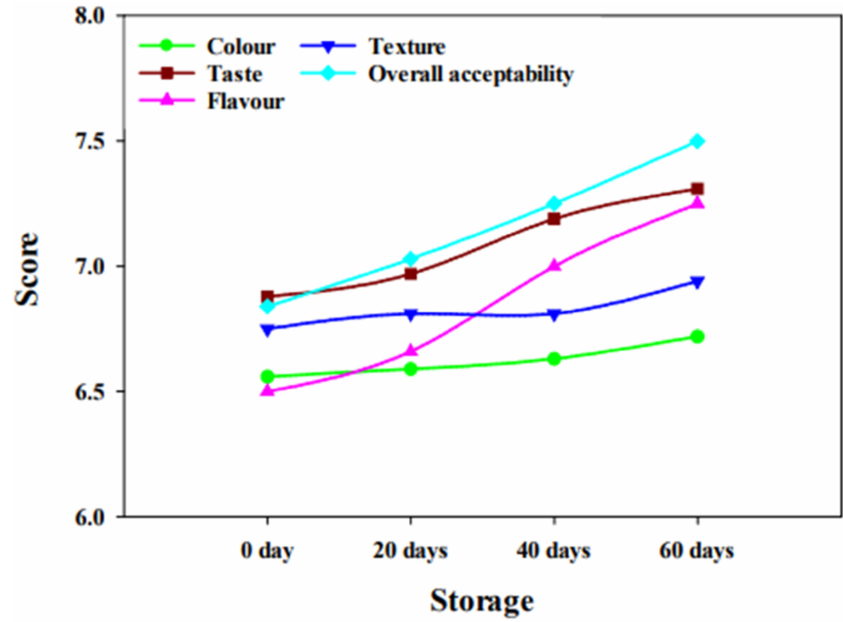
Figure 2. Effect of ripening on sensory properties of cheese.